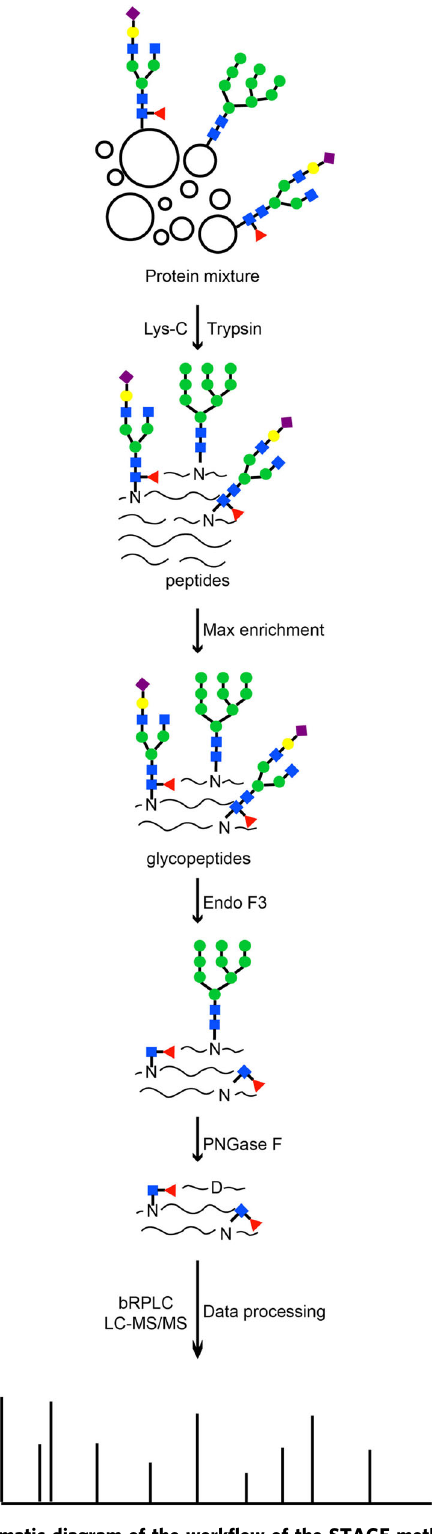
Fig. 1 Schematic diagram of the work fl ow of the STAGE method. Blue square: N -acetylglucosamine, Green circle: mannose, Yellow circle: galactose, Red triangle: fucose, Purple diamond: sialic